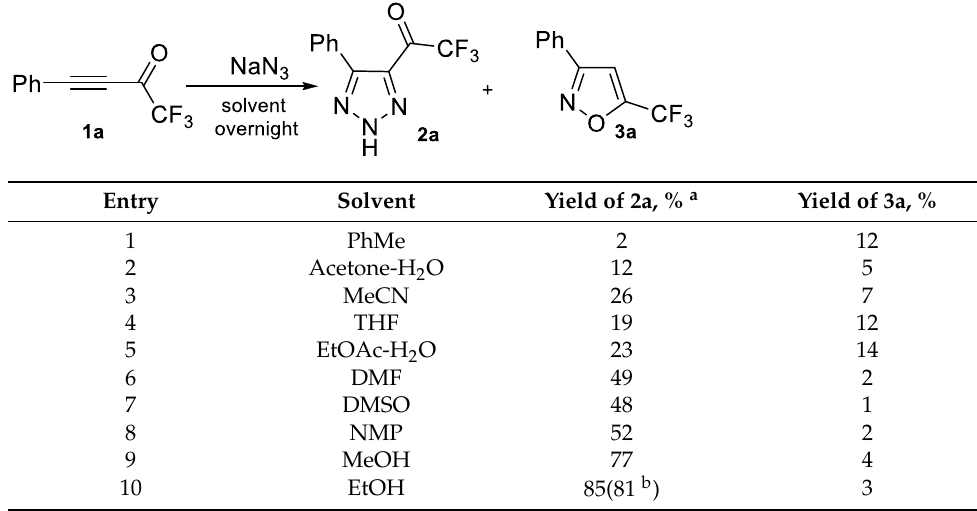
Table 1. Investigation of the solvents’ nature in the reaction of sodium azide with CF 3 -ynone 1 .